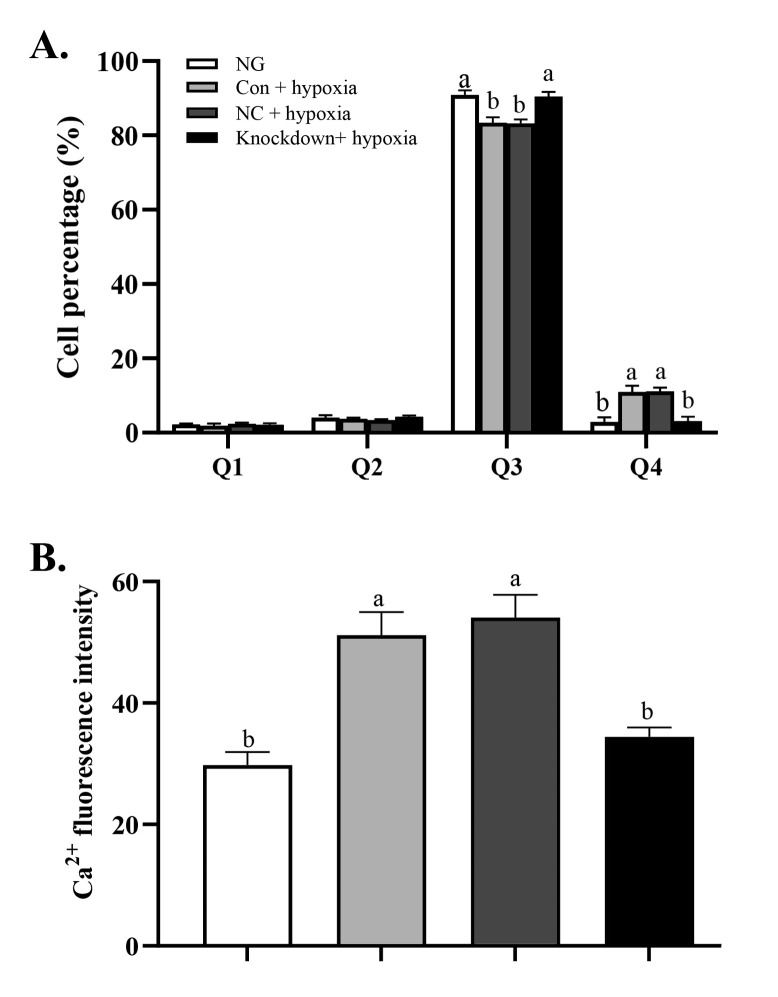
Effect of CaSR knockdown on apoptosis and Ca2+ concentration in hepatocytes of GIFT under hypoxia stress.(A) Proportion of apoptotic cells in NG, knockdown+ hypoxia, NC+ hypoxia and Con+ hypoxia groups. Figure shows percentages of dead cells (Q1), late apoptotic cells (Q2), viable cells (Q3), and early apoptotic cells (Q4). (B) Ca2+ fluorescence intensity in NG, knockdown+ hypoxia, NC + hypoxia, and Con + hypoxia groups. Different lowercase letters indicate significant differences among experimental groups (Duncan’s multiple range test, P < 0.05).